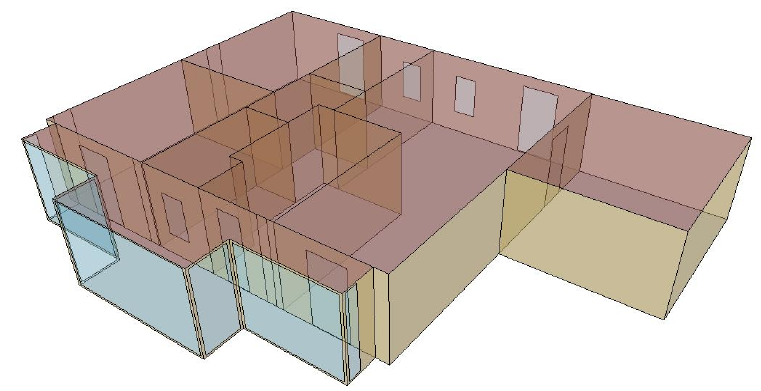
Figure 7. Three-dimensional model of the flat with the